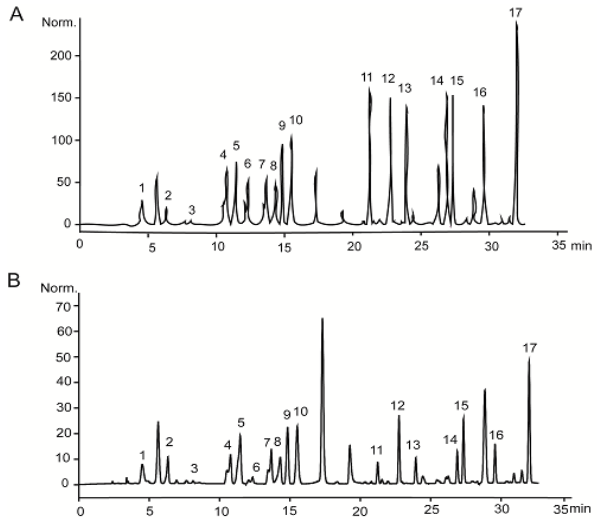
Figure 3. HPLC analysis of amino acids standard ( A ), and PSAF ( B ). Peaks: 1, Aspartic acid; 2, Glutamic acid; 3, Cysteine; 4, Serine; 5, Glycine; 6, Histidine; 7, Arginine; 8, Threonine; 9, Alanine; 10, Proline; 11, Tyrosine; 12, Valine; 13, Methionine; 14, Isoleucine; 15, Leucine; 16, Phenylalanine; 17, Lysine.